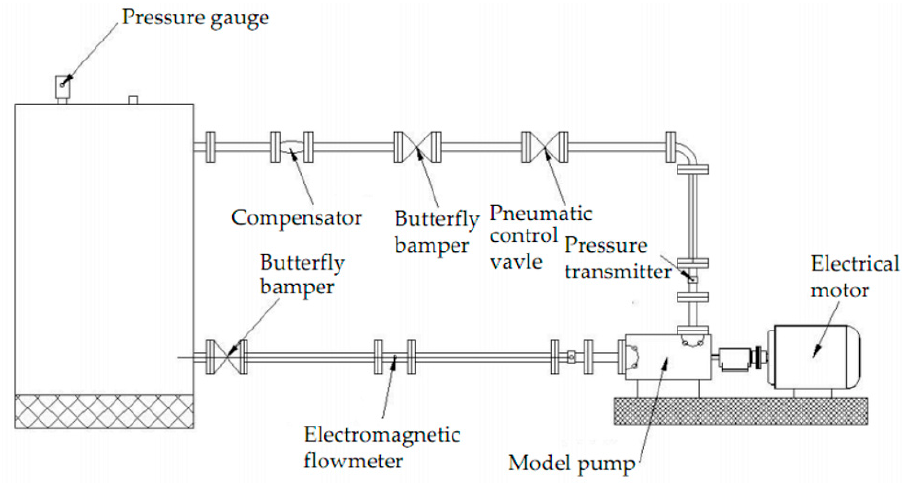
Figure 5. 2D sketch of the experimental test rig.